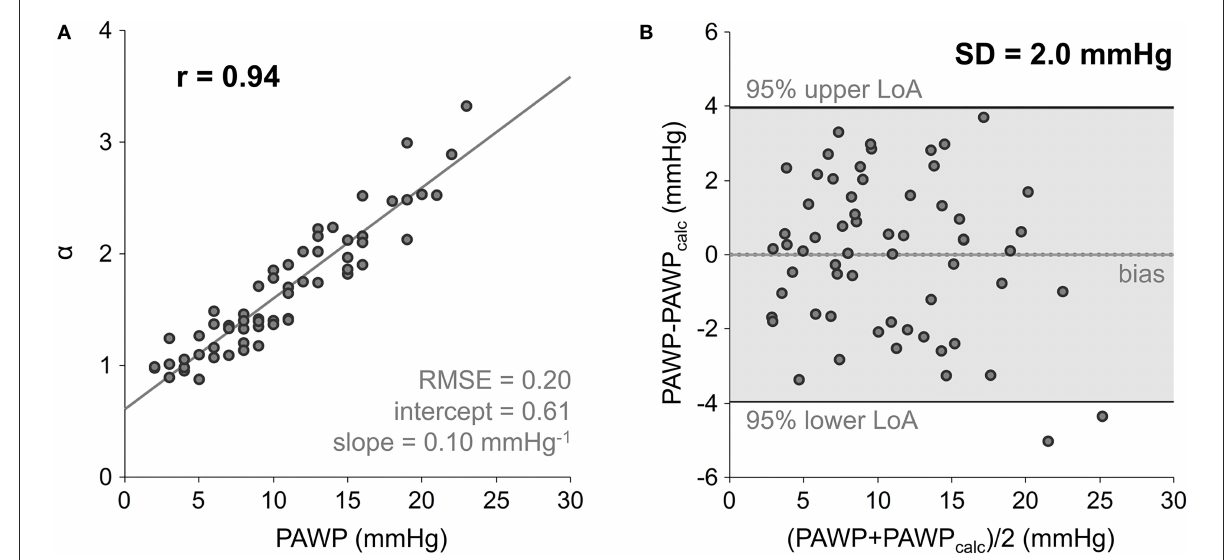
FIGURE3 Scatter plot and linear regression of LA acceleration factor α on PAWP (A) , and Bland-Altman plot comparing RHC-derived PAWP and PAWP calc calculated from inverted linear regression equation (B) . PAWP, mean pulmonary artery wedge pressure; RMSE, root-mean-square error; LoA, limits of agreement; SD, standard deviation of